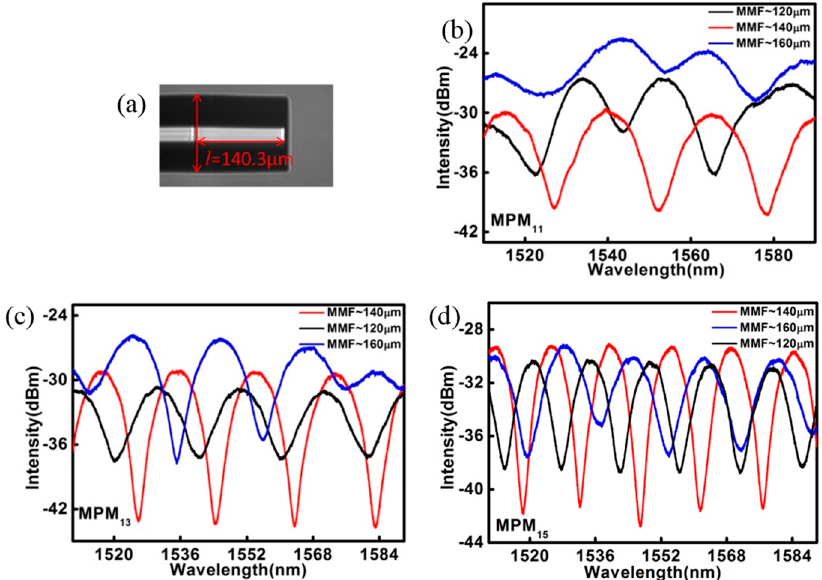
Figure 3. ( a ) The micrograph of MMF, and the transmitted spectra with different lengths of MMF for ( b ) MPM 11 ; ( c ) MPM 13 ; and ( d ) MPM 15 .